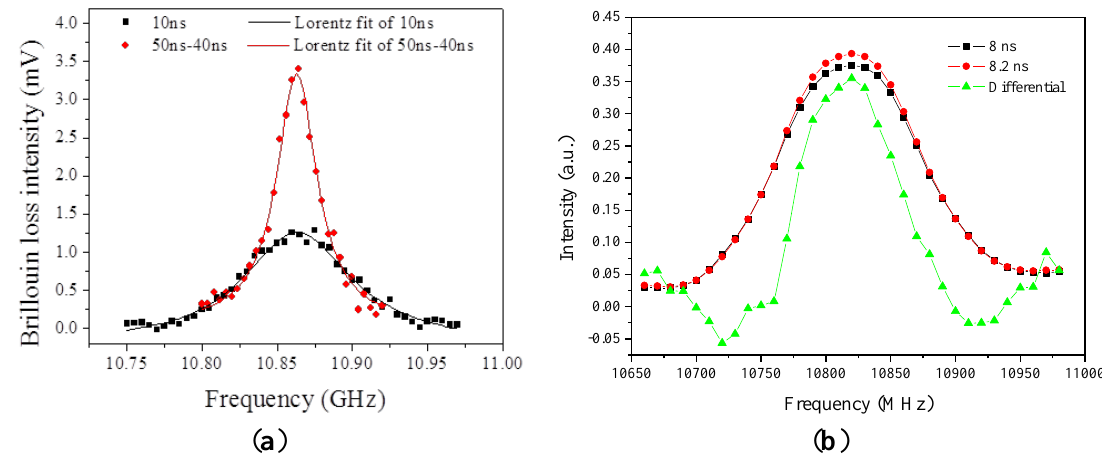
Figure 6. Experimental results of the differential gain for the pulse width larger than phonon lifetime ( a ) and smaller than phone lifetime ( b